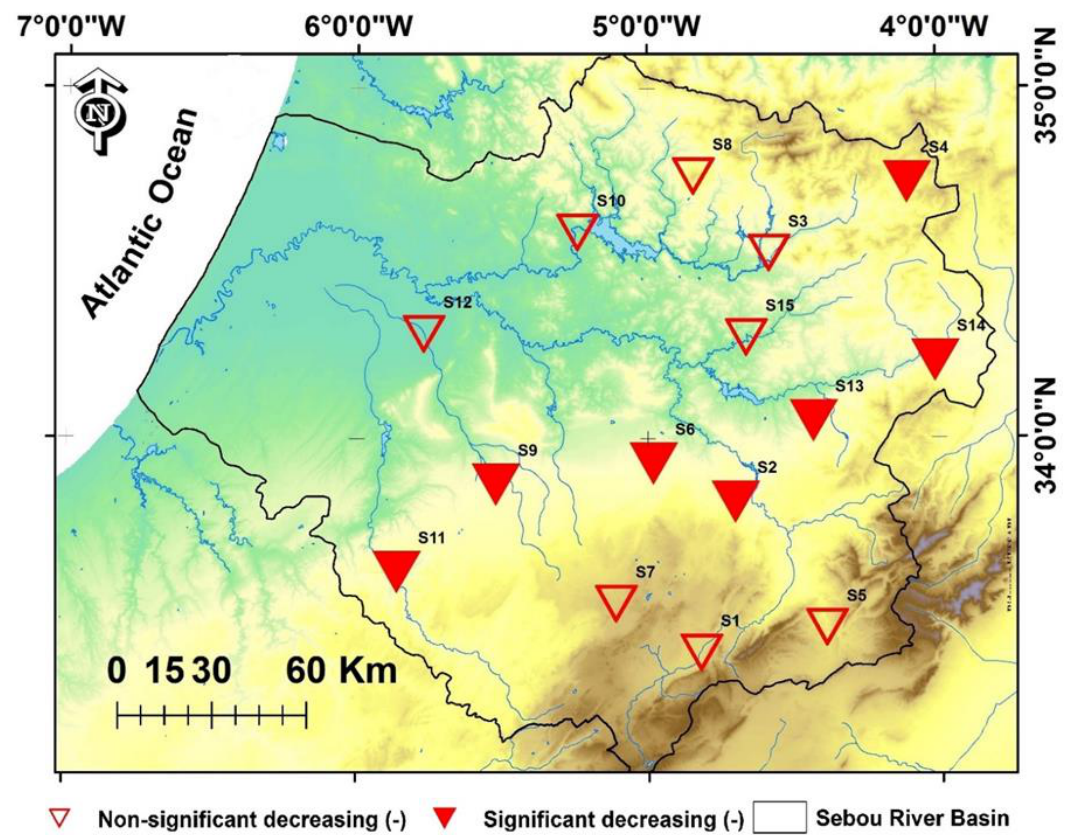
Figure 4. The Mann – Kendall test results in the SRB for annual rainfall at the 95% CL. Figure 4. The Mann–Kendall test results in the SRB for annual rainfall at the 95%